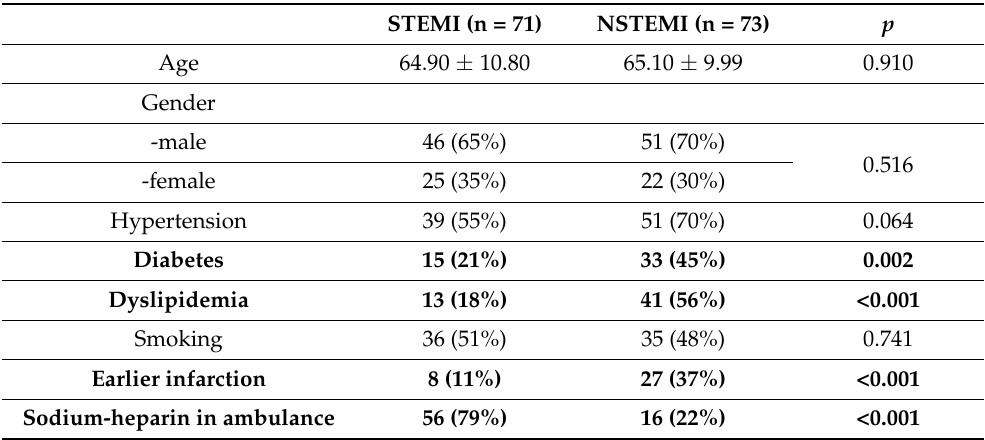
Table 1. Demographic data comparing STEMI and NSTEMI patients. Receiving sodium-heparin in ambulance being more common in the earlier, whereas diabetes, dyslipidemia, and previous myocardial infarction in the latter.